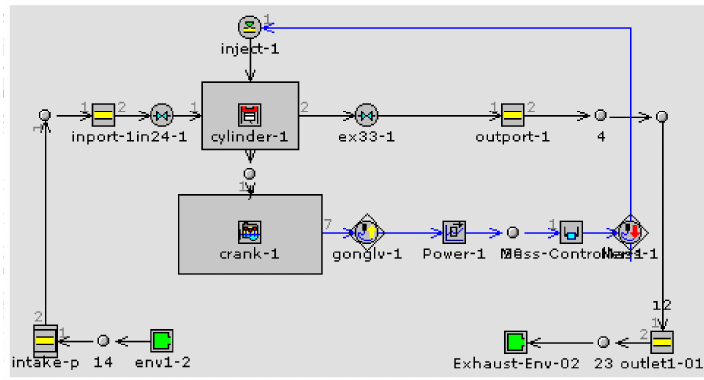
Figure 4. Equivalent model of OP2S-GDI engine.